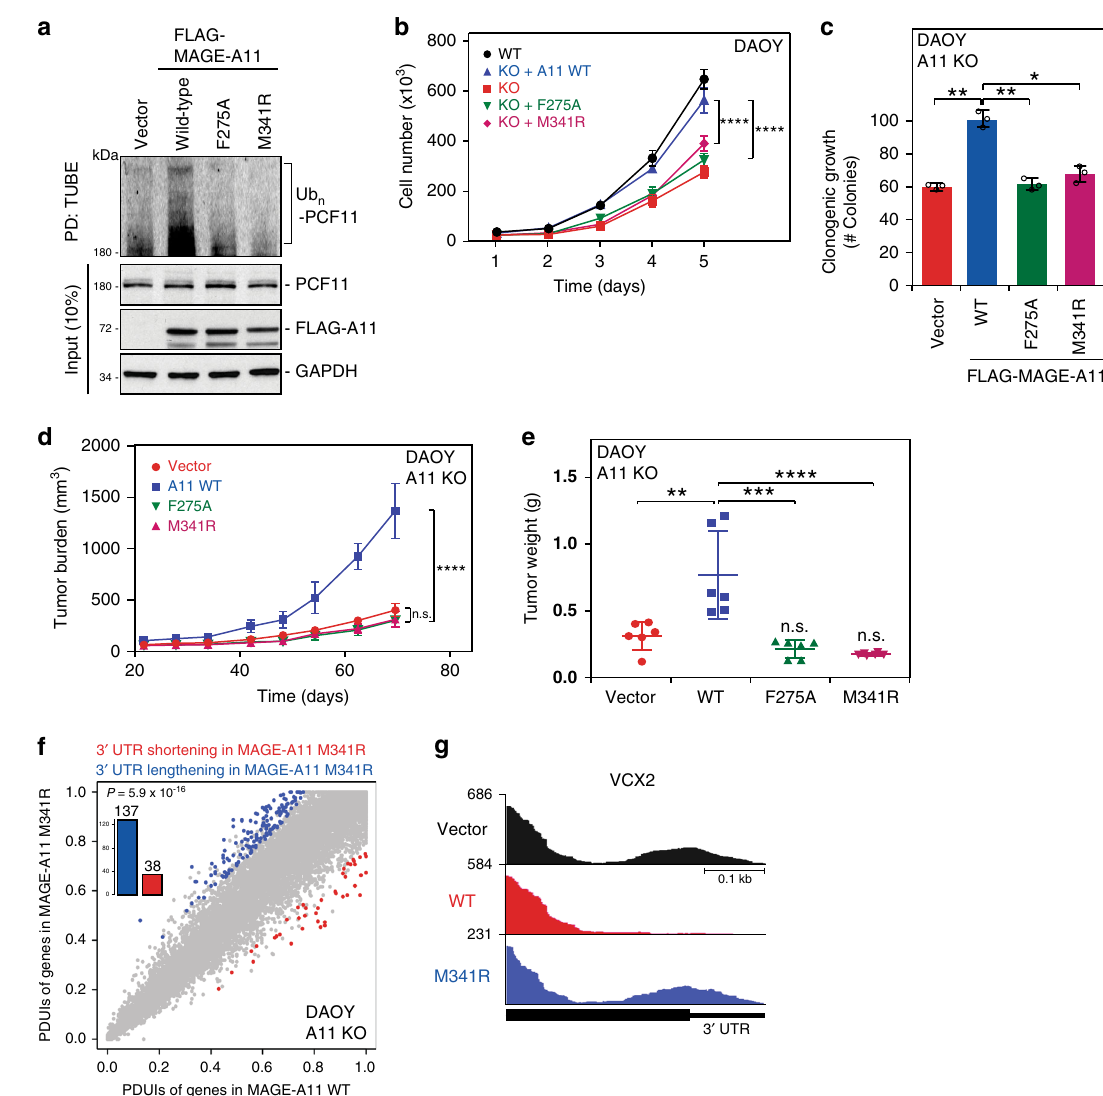
Fig. 3 Mutation of MAGE-A11 SBC disrupts its oncogenic activity. a MAGE-A11-induced ubiquitination of PCF11 depends on its substrate recognition by MAGE-A11 SBC. Ubiquitinated proteins from FLAG-vector, FLAG-MAGE-A11 wild-type, or SBC mutants stably expressing HEK293FT cells were treated with 10 µ M MG132 for 4 h and isolated with tandem ubiquitin binding entity-agarose followed by SDS-PAGE and immunoblotting for endogenous PCF11. Source data are provided as a Source Data fi le. b MAGE-A11 SBC mutants fail to promote proliferation of MAGE-A11 knockout DAOY cells. Wild-type, MAGE-A11-knockout DAOY cells, or those reconstituted with MAGE-A11 were counted for cell proliferation at the indicated time points ( n = 3 biologically independent experiments per group). Data are mean ± SEM. p -value by two-way ANOVA followed by Tukey ’ s multiple comparisons test is indicated (**** P < 0.0001). c – e MAGE-A11 knockout DAOY cells reconstituted with MAGE-A11 SBC mutants reduced clonogenic growth and xenograft tumor growth of MAGE-A11 knockout DAOY cells. Stable expression of wild-type MAGE-A11 or SBC mutants in MAGE-A11-knockout DAOY cells were assayed for clonogenic growth ( c ) ( n = 3 biologically independent experiments per group, two-tailed unpaired Student ’ s t test, * P < 0.05; ** P < 0.01), Data are mean ± SEM and xenograft tumor growth in mice ( n = 6 per group). Tumor burden ( d ) and tumor weight ( e ) are shown. Data are mean ± SD. p -value by two-way ANOVA followed by Tukey ’ s multiple comparisons test is indicated in d (**** P < 0.0001), ordinary one-way ANOVA followed by Sidak ’ s multiple comparisons test is indicated in e (** P < 0.01, *** P < 0.001, **** P < 0.0001). Red circle, Vector; Blue square, MAGE-A11 WT; Green triangle, MAGE-A11 F275A; and Pink triangle, MAGE-A11 M341R. f MAGE-A11 M341R mutant fails to promote mRNA 3 ’ UTR shortening. Transcriptome analysis of tumors ( n = 3 per group) from MAGE-A11 knockout DAOY cells stably expressing FLAG-MAGE-A11 wild-type or M341R mutant was determined and scatterplot of Percentage of Distal polyA site Usage Index (PDUI) is shown. False discovery rate ≤ 0.05 and Δ PDUIs ≥ 0.2 are colored. The shift towards distal polyadenylation site is signi fi cant ( p = 5.9 × 10 − 16 , binomial test). g Representative RNA-seq density plots are shown.